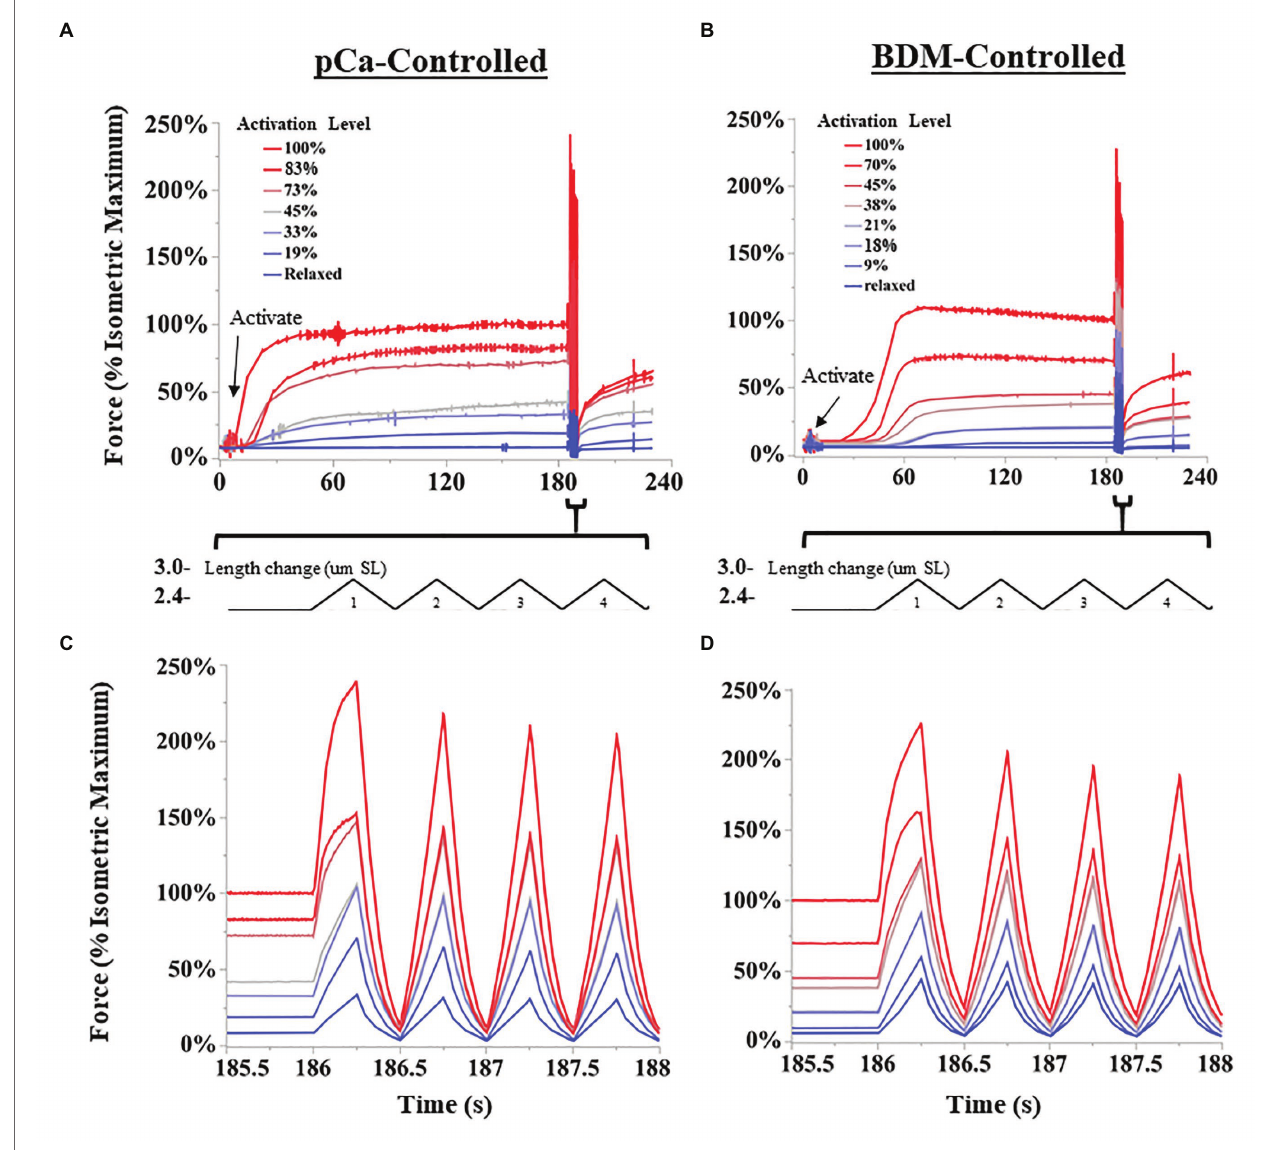
FIGURE 2 | Representative SSC experiments from permeabilized fiber bundles. Activation levels were controlled either by decreasing the concentration of calcium ions (pCa; A,C ), or by 2,3-butanedione monoxime (BDM)-induced myosin inhibition (B,D) . Length changes were performed using a “triangular” length trajectory between 2.4 and 3.0 μ m SL at 2 Hz. (A,B) show all force trials collected for a representative fiber bundle for pCa-controlled and BDN-controlled fibers, respectively. Bundles were activated until force leveled off, and then subjected to multiple SSCs. (C,D) show the first four cycles at a higher time resolution for pCa and BDM trials,